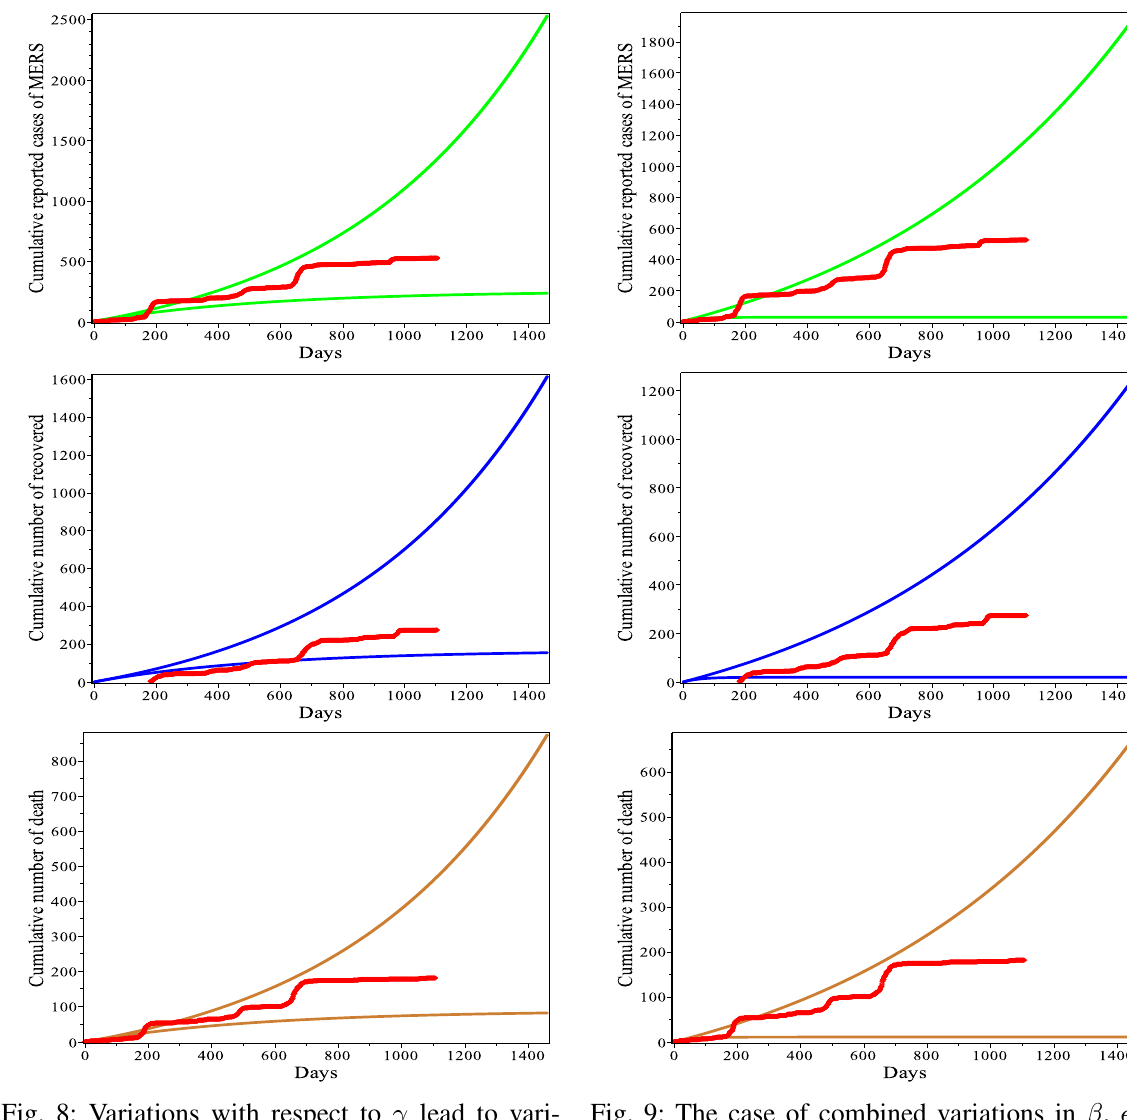
cases of MERS (left) show that the envelopes reach maximum values of about 1978 and 31 , respectively. The cumulative numbers of recovered (middle) reach maximum values of about 1268 and 20 , respectively. The cumulative number of deaths (right) reach maximum values of about 684 and